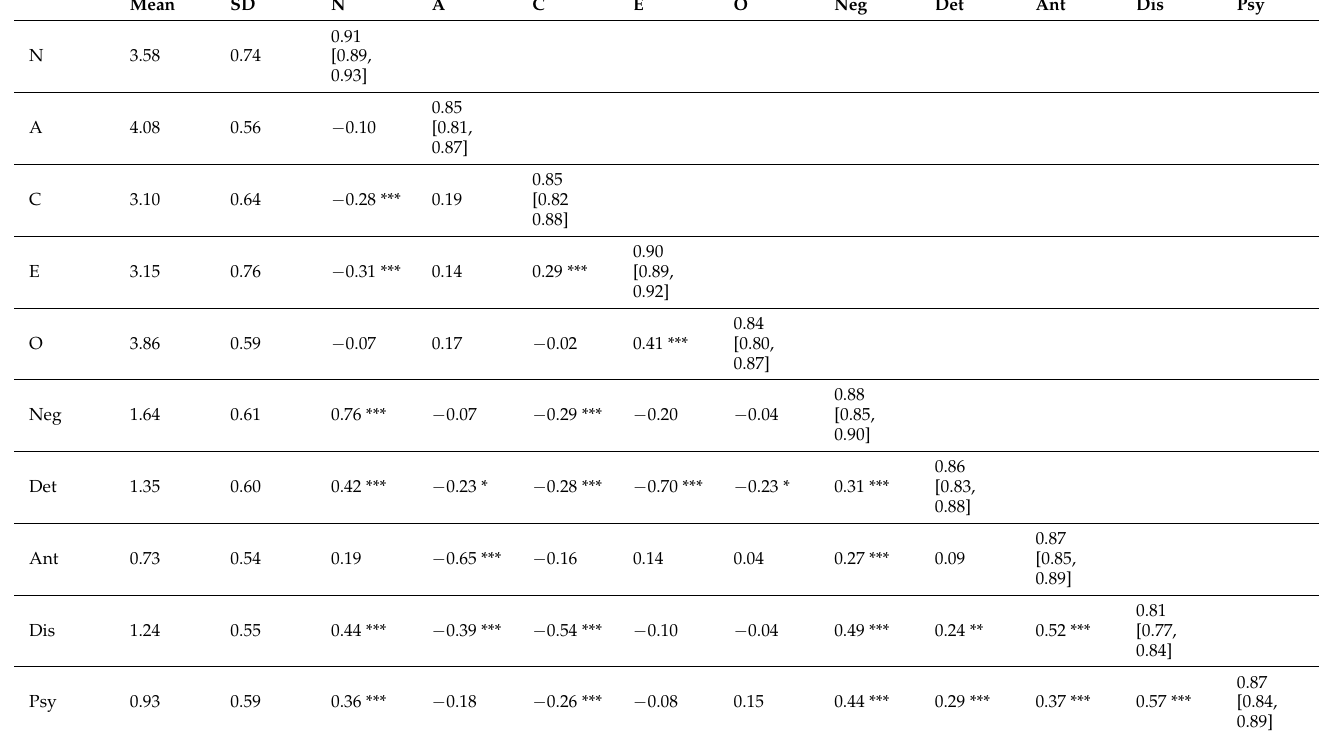
Table 1. Means, Standard Deviations, Reliabilities, and Bivariate Bayesian Pearson’s rho Correlations between the Five-Factor Model and Alternative Model of Personality Disorder